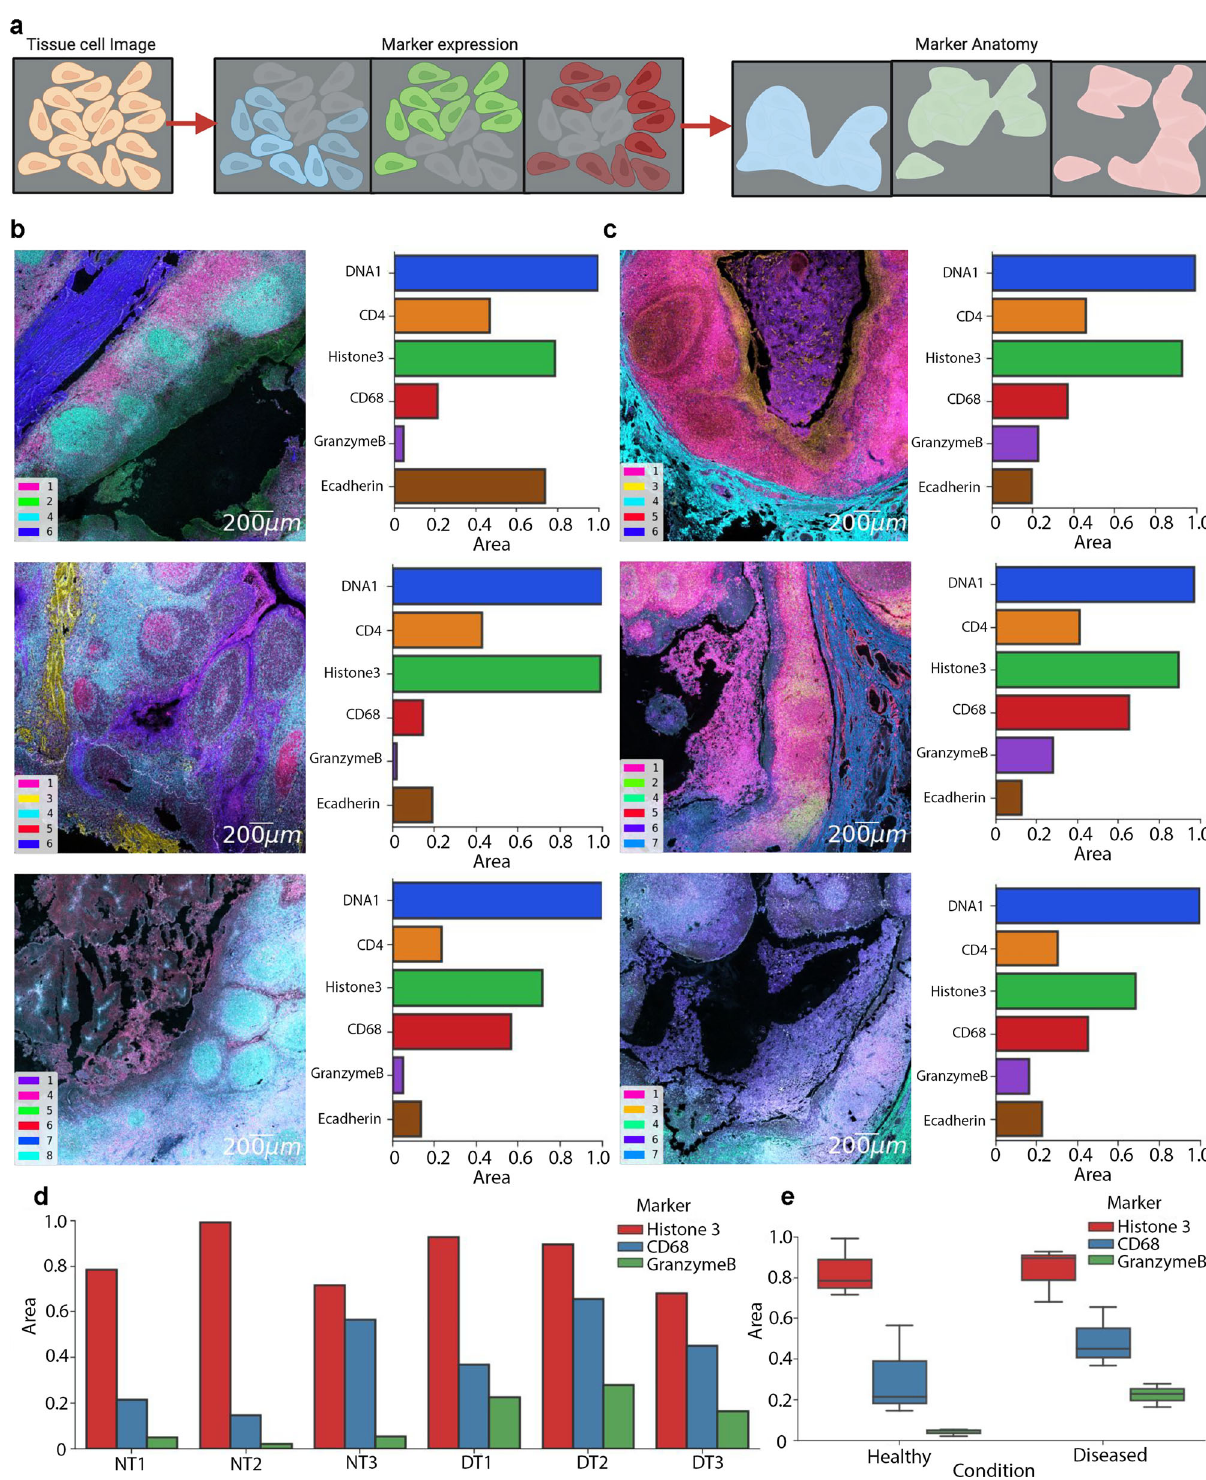
Fig. 3 CD68 cells and Granzyme B marker coexpression and large morphological shared presence in chronic tonsillitis. a Schematics of the de fi nition of anatomical regions based on multiplexed marker data are presented. Created in Biorender.com. b Morphological analysis of area ratios of DNA1, CD4, H3, CD68, Granzyme B, and E-cadherin markers in normal tonsil tissues is demonstrated. The scale bar is 200 µ m. c Morphological coverage of the same subset of markers in diseased tonsil tissues is shown. d Bar plots for area ratios of Histone3, CD68, and Granzyme B markers in three normal tonsils (NT) and three diseased tonsils (DT) datasets are plotted. e Box plots of the mean area ratio of Histone3, CD68, and Granzyme B markers that were averaged from three sets of NT and DT data. Box plots show median fi rst and third quartile, minimum, and maximum (excluding